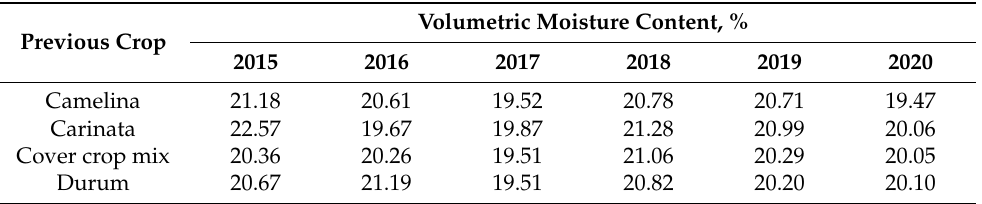
Table 2. Mean values of volumetric moisture content (%) across 0–20 cm depth as affected by